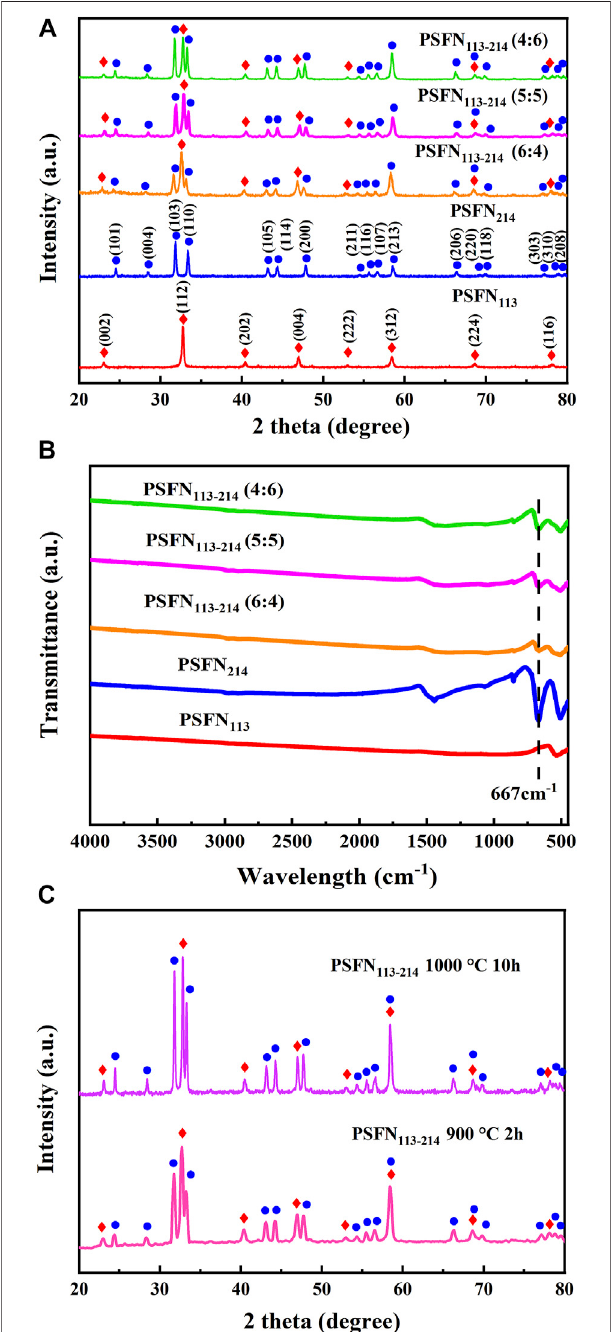
FIGURE 1 | (A) XRD of cathode powder; (B) infrared spectrum of cathode powder; (C) XRD of PSFN 113-214 mixed in equal proportion at different calcination temperatures.